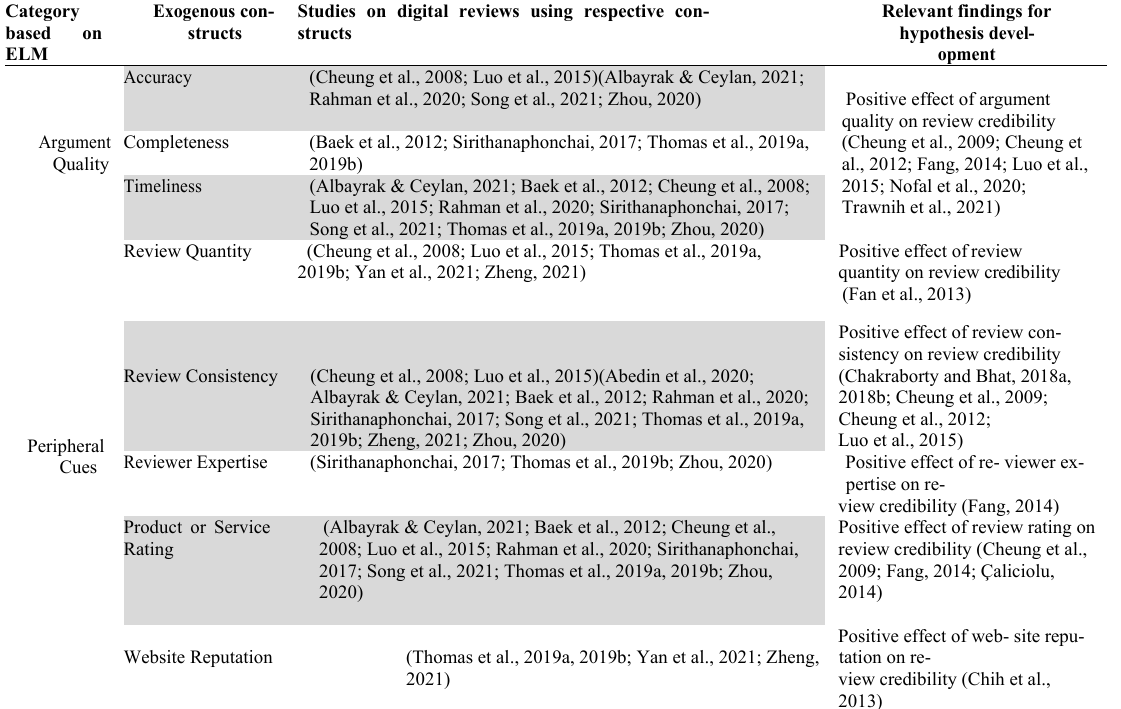
Overview of Exogenous Constructs and Relevant Sources for Model